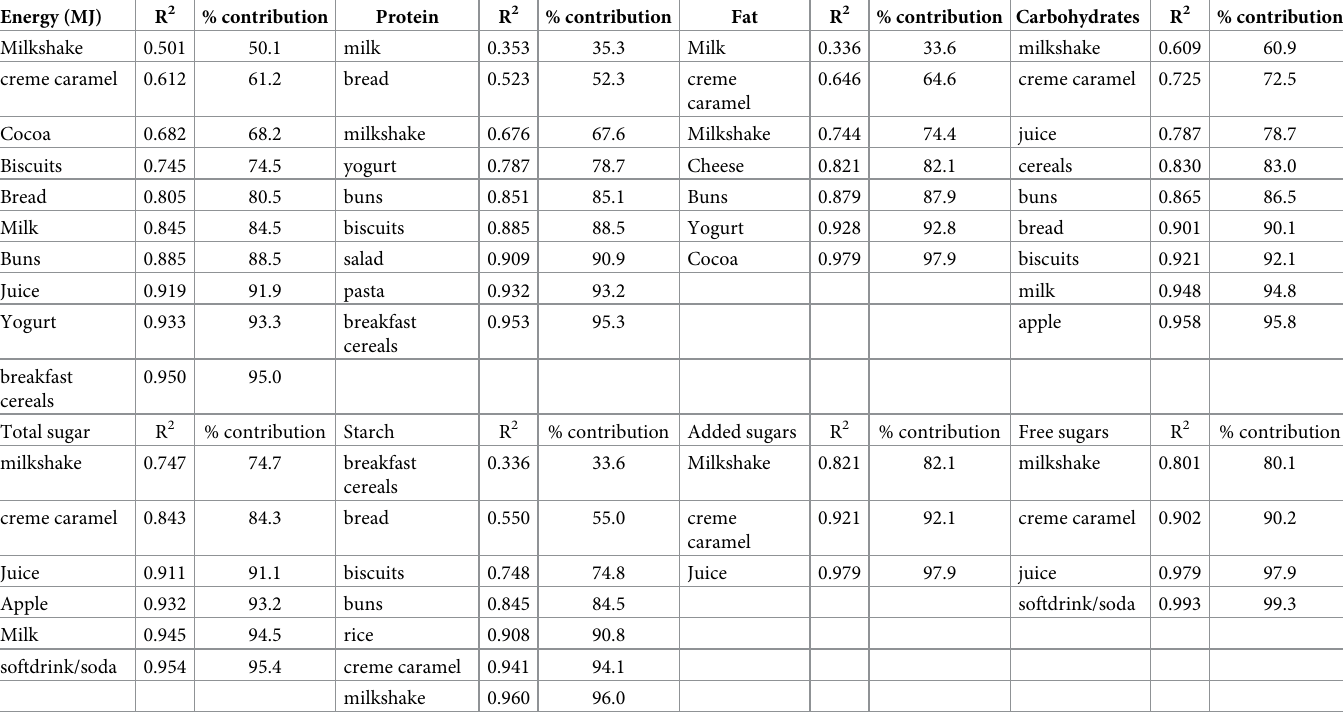
Table 2. Stepwise regression analysis of the contribution of each food to the total nutrient intake of the children. Energy (MJ) R 2